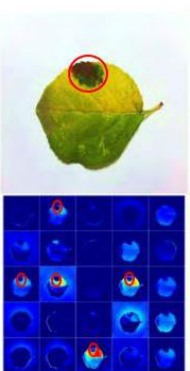
Figure 10. Activation visualization for detection of apple plant disease to show the significance of a VGG-Inception model (the plant disease is indicated by the red circle) [85] .